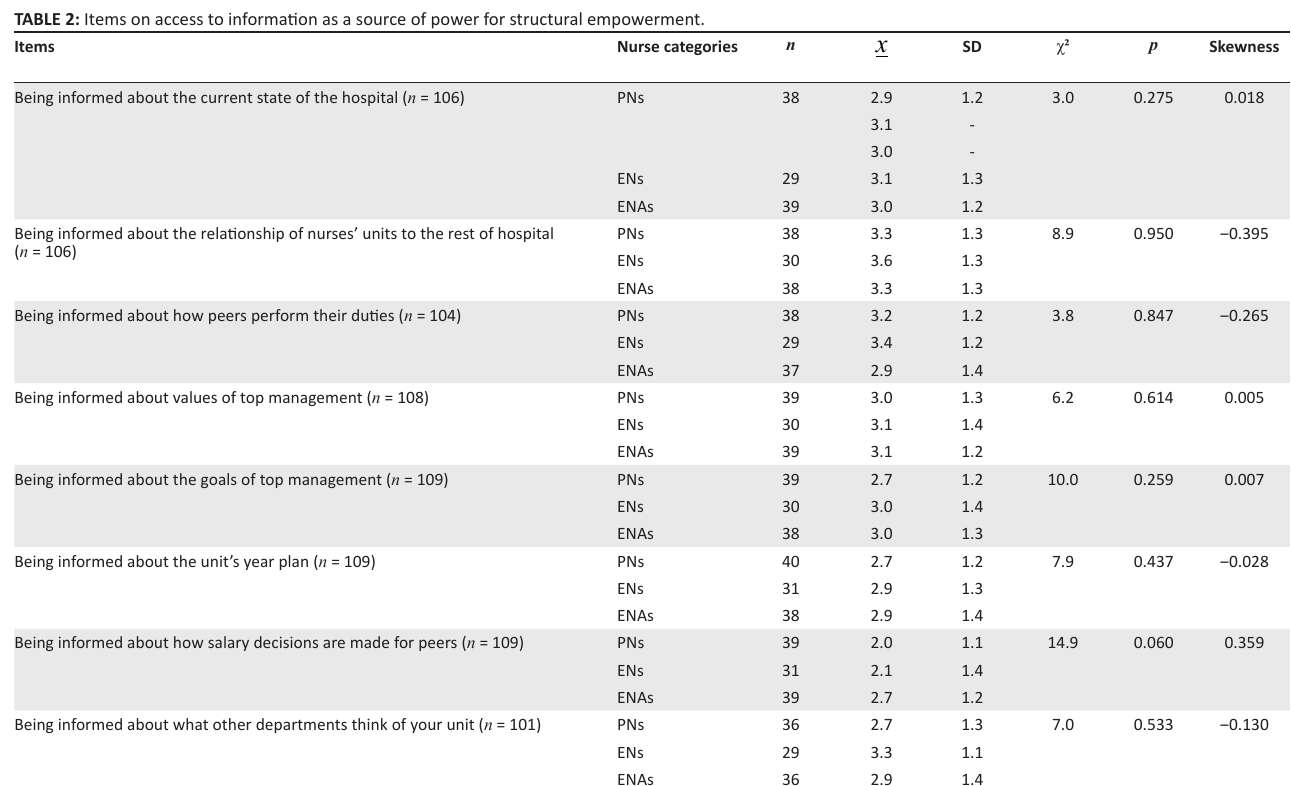
TABLE 2: Items on access to information as a source of power for structural empowerment.